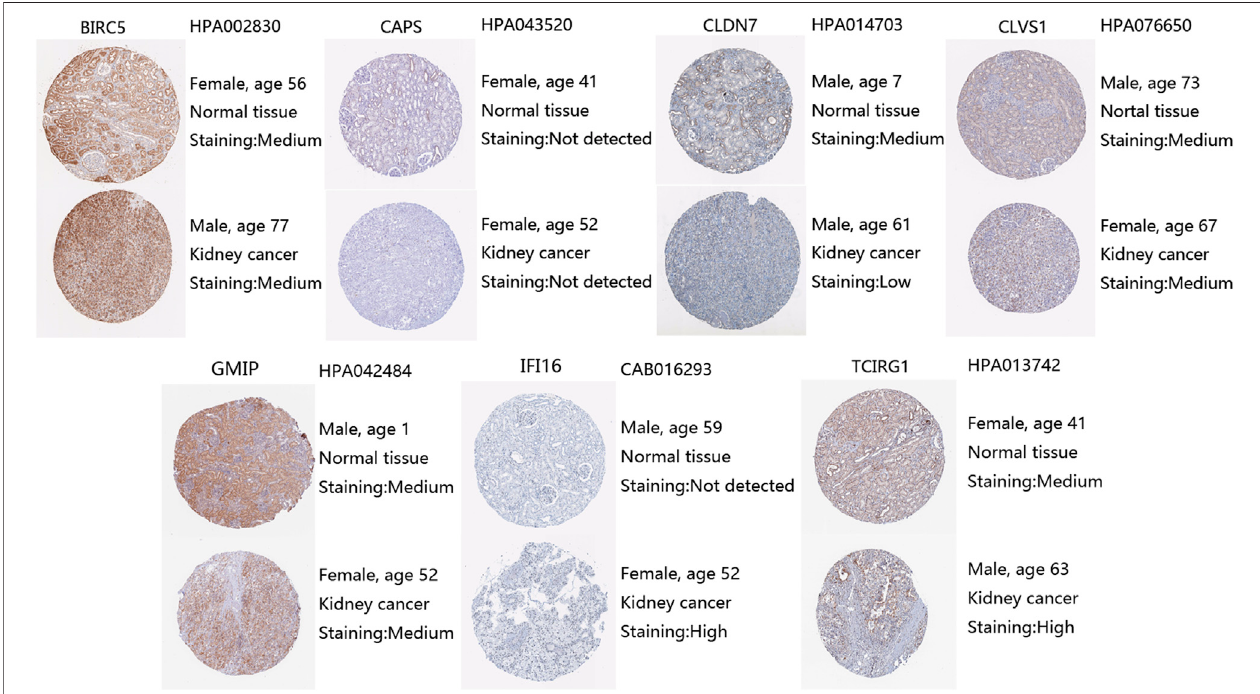
FIGURE 3 | Protein expression levels of DEGs from HPA, antibody, and patient information were listed as well.